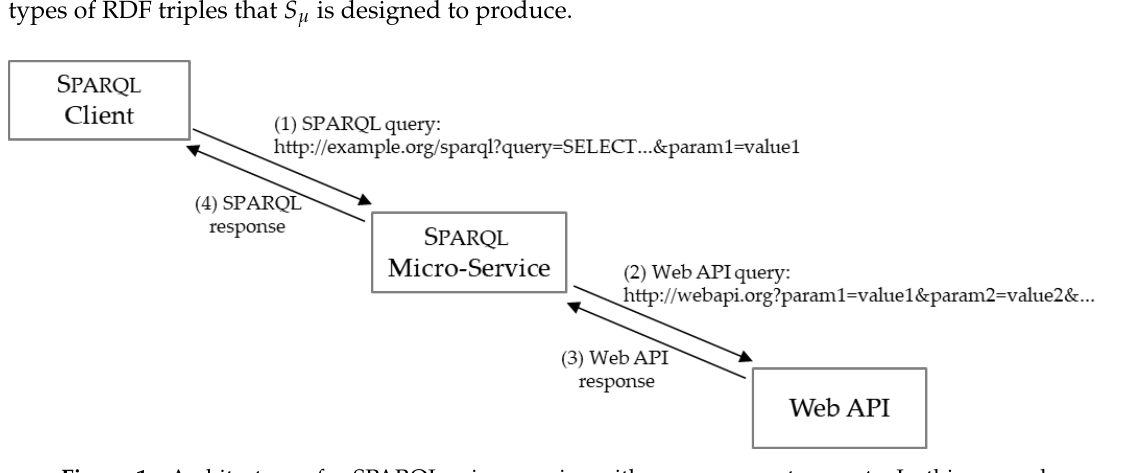
Figure 1. Architecture of a SPARQL micro-service with one argument param1 . In this example, the argument is passed as a parameter on the HTTP query